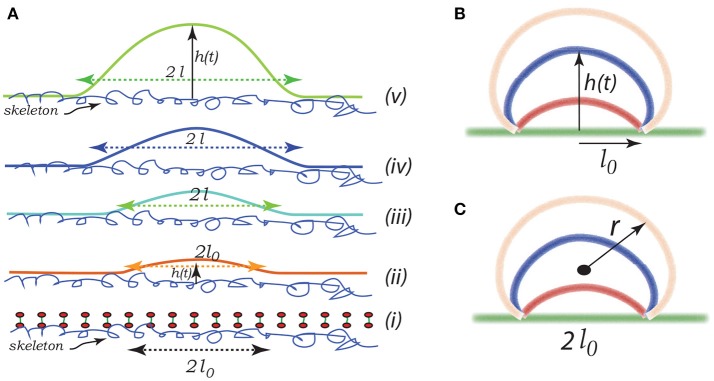
Schematic of a budding vesicle. In (Aii) we illustrate a pre-curvature as discussed in the text. From (Aiii to Av) we have progressing membrane bulging leading to vesiculation. (B,C) depict a model expansion analyzed below. Vesiculation begins within a damaged membrane/skeleton area of diameter 2ℓ0. Driven by release of stored skeletal energy a bulge forms and possibly grows as in (B,C) where the energy pathway is given in Figure 11. The final stage of pinching-off and vesicle release in illustrated in Figure 12.